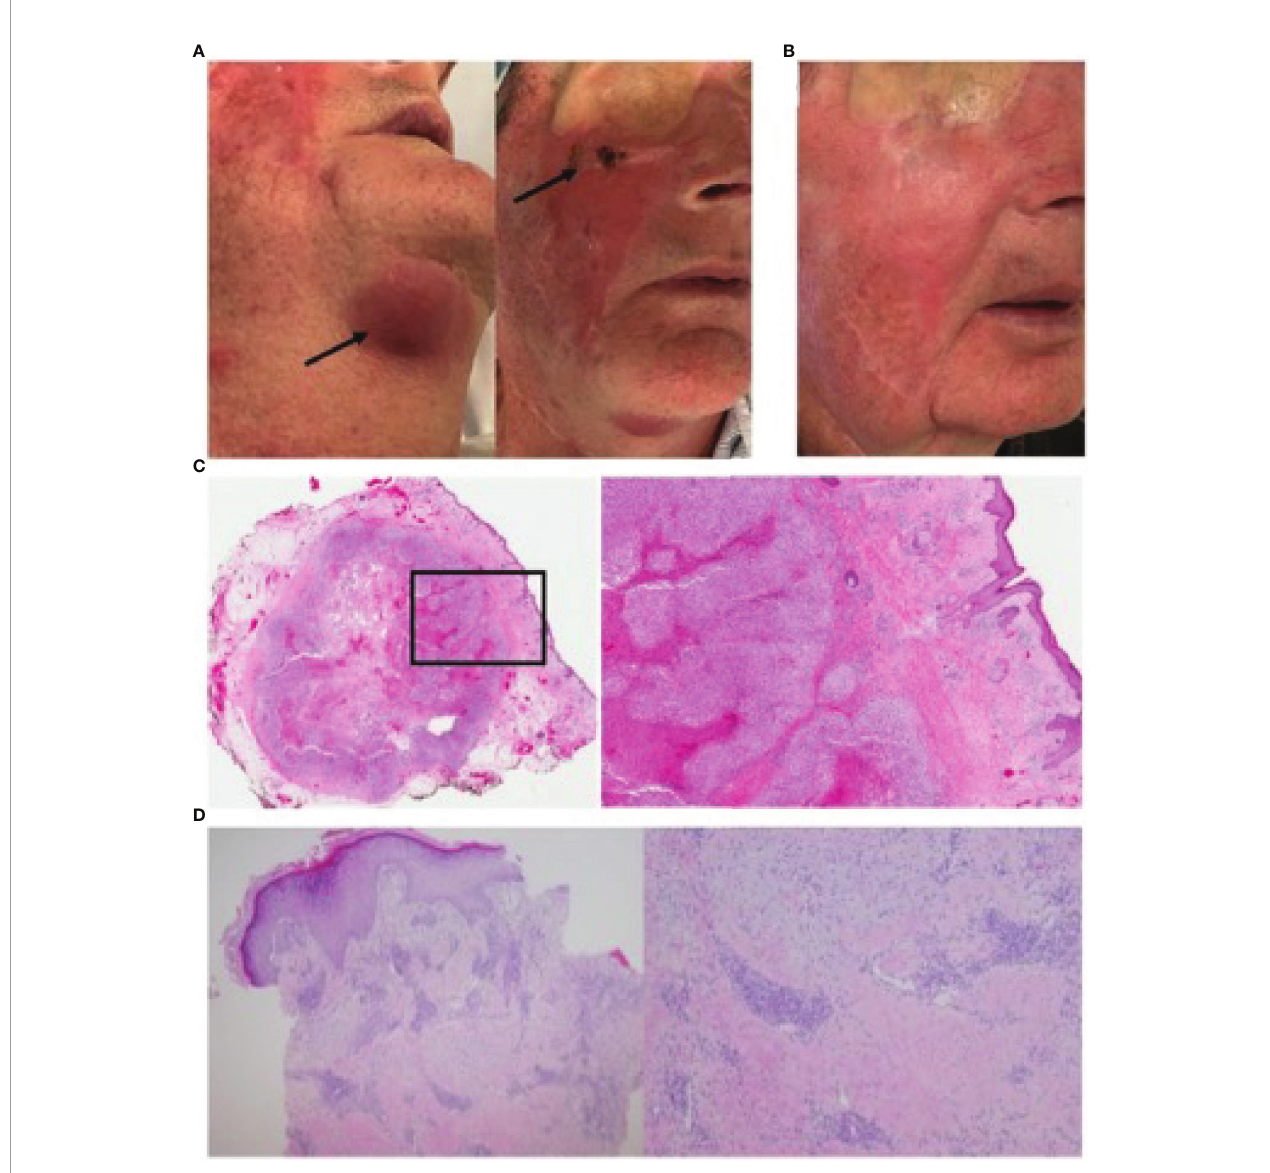
FIGURE 2 | Post-treatment course with intra-lesional IL2 and imiquimod. (A) Complete response of facial lesions with resolving submandibular nodule. Arrows identify nodule and infraorbital area of healing (biopsied) skin. (B) Sustained complete resolution of facial cSCC three months following completion of treatment. (C) (left) Histological pro fi le of excised submandibular nodule low magni fi cation; (right) 20X magni fi cation reveals residual high-grade cSCC with necrosis, a pronounced lymphocytic in fi ltrate, with no evidence of nodal tissue (D) (left) 40X magni fi cation of biopsied, healing infraorbital skin showing ulceration and complete clearance of cSCC; (right) 100X magni fi